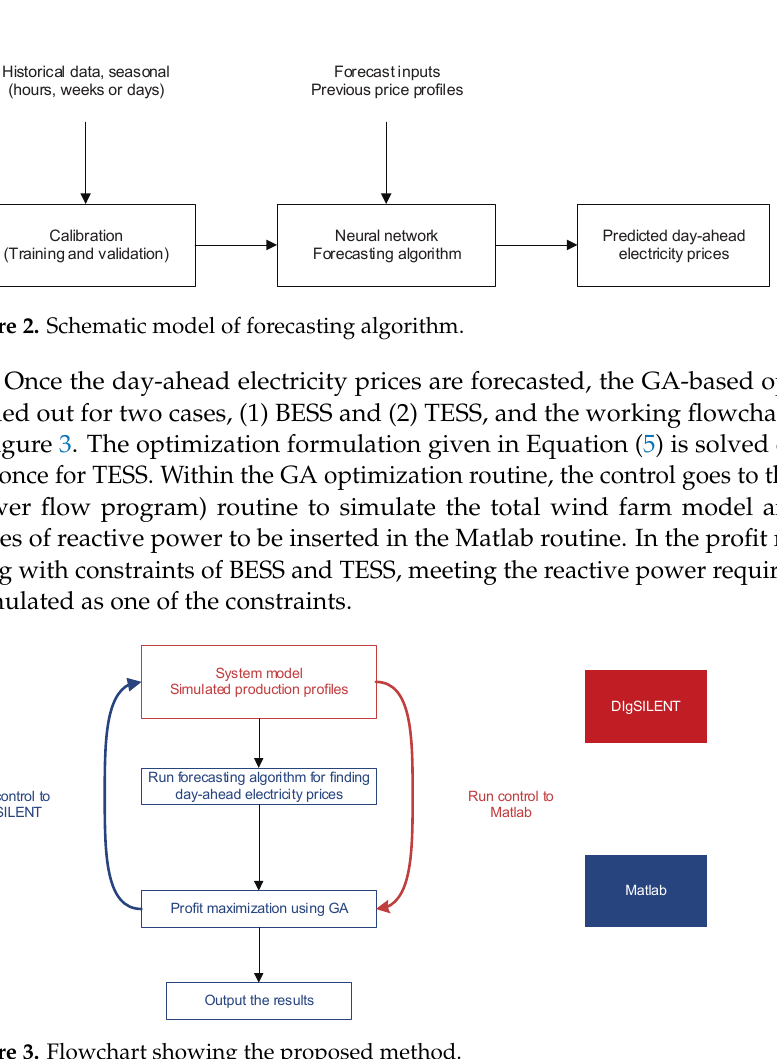
(cid:3) Figure 3. Flowchart showing the proposed